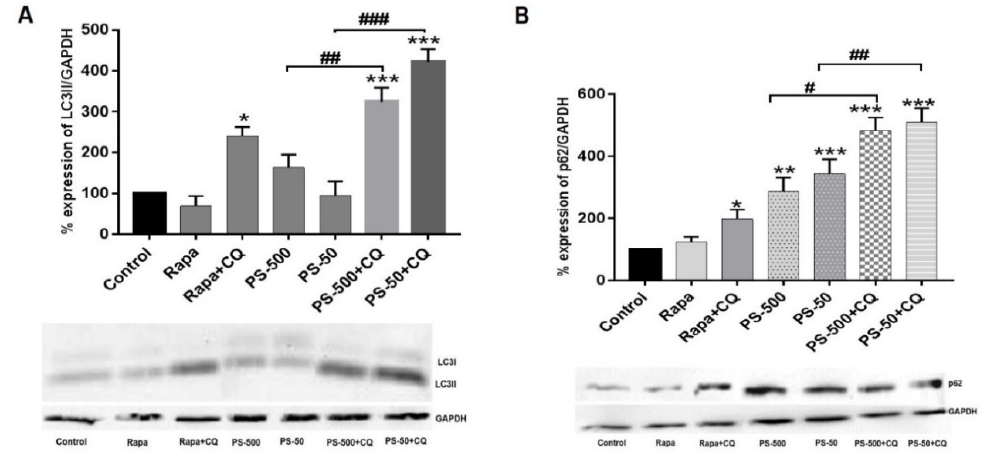
Figure 6. Images showing the expression of important autophagy pathway proteins: LC3-II and p62 after exposure of HNEpCs to PS-50 and PS-500 alone or their combination with chloroquine for 24 h. ( A ) Histogram showing the quantitative changes in the levels of LC3-II expression in treated and untreated cells (top) and the respective Western blot for LC3-II (bottom). ( B ) Histogram showing the quantitative changes in the levels of p62 expression in the treated and untreated cells (top) and respective Western blot for p62 (bottom). * p ≤ 0.05, ** p ≤ 0.01, *** p ≤ 0.001 vs. untreated control; # p ≤ 0.05, ## p ≤ 0.01, ### p ≤ 0.001 (PS-50/PS-500 vs. PS-50/PS-500 + CQ). Note: Rapa and CQ in the graphs and blots represent rapamycin and chloroquine, respectively.